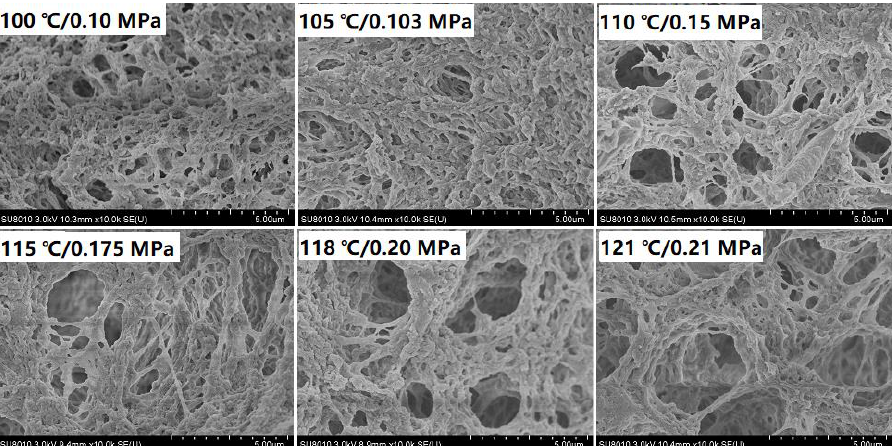
Figure 5. SEM images (10,000×) of CMP heat-induced gel obtained by various AT.